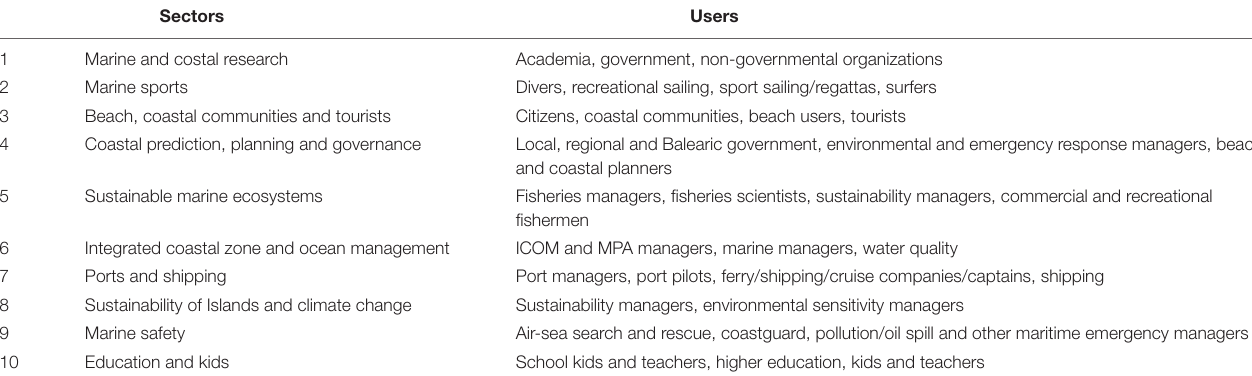
TABLE 2 | SOCIB products and services: identified sectors and users (Heslop et al., 2019).